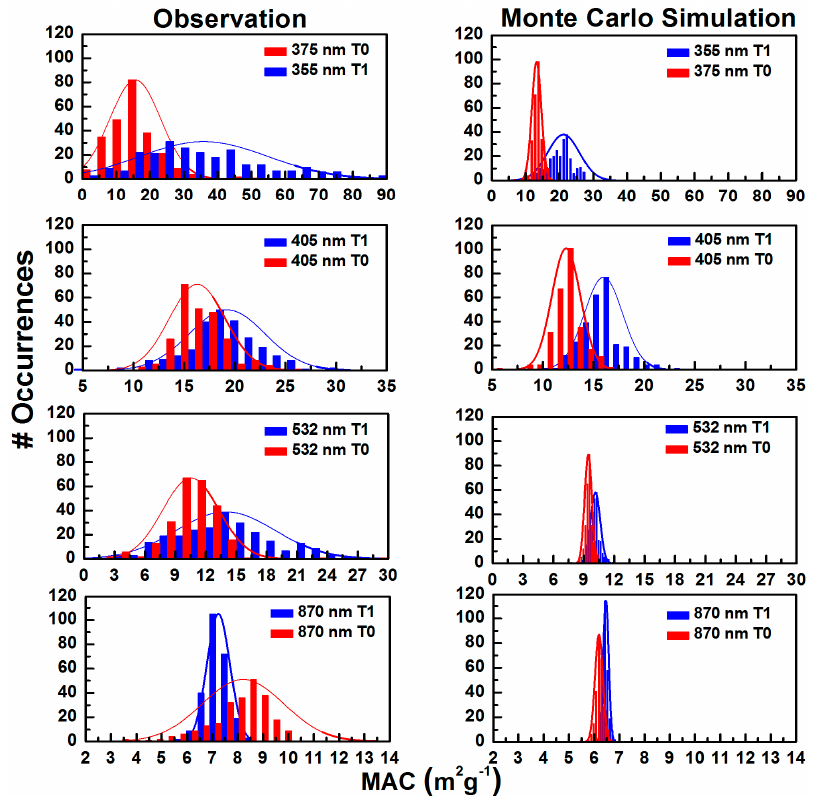
Figure 5 . Histograms of observed (left panel) and modeled (Monte Carlo, right panel) BC mass normalized absorption cross-section ( MAC ) overlaid with the normal distributions for 22–28 June 2010 at T0 and T1. The Monte Carlo simulation considers only the measurement uncertainties of PA and SP2. The modeled analysis represents the MAC distribution of each wavelength obtained from the regression.